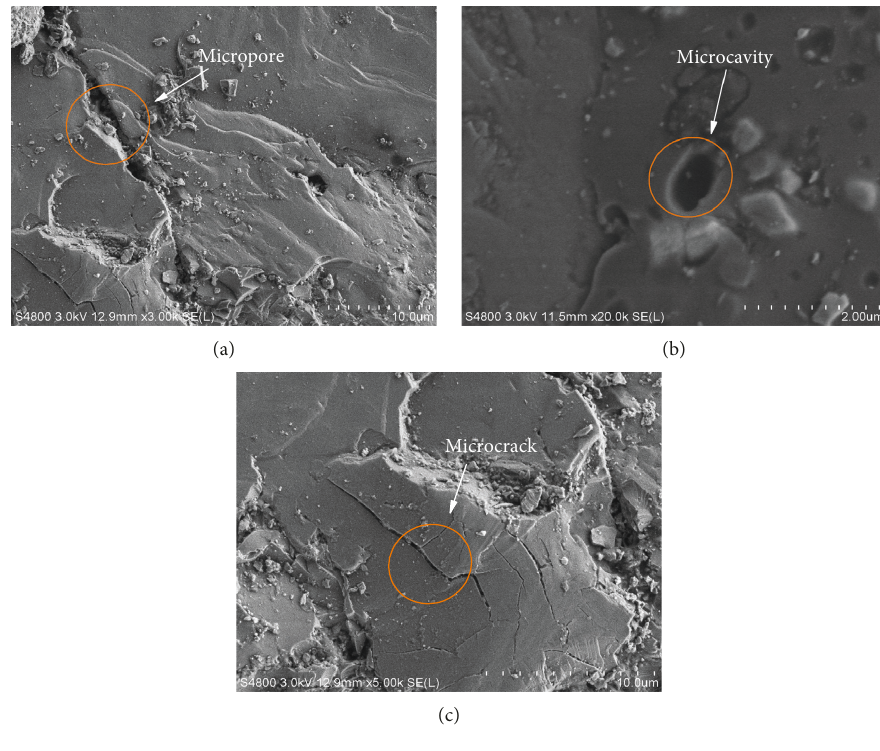
Figure 8: The original